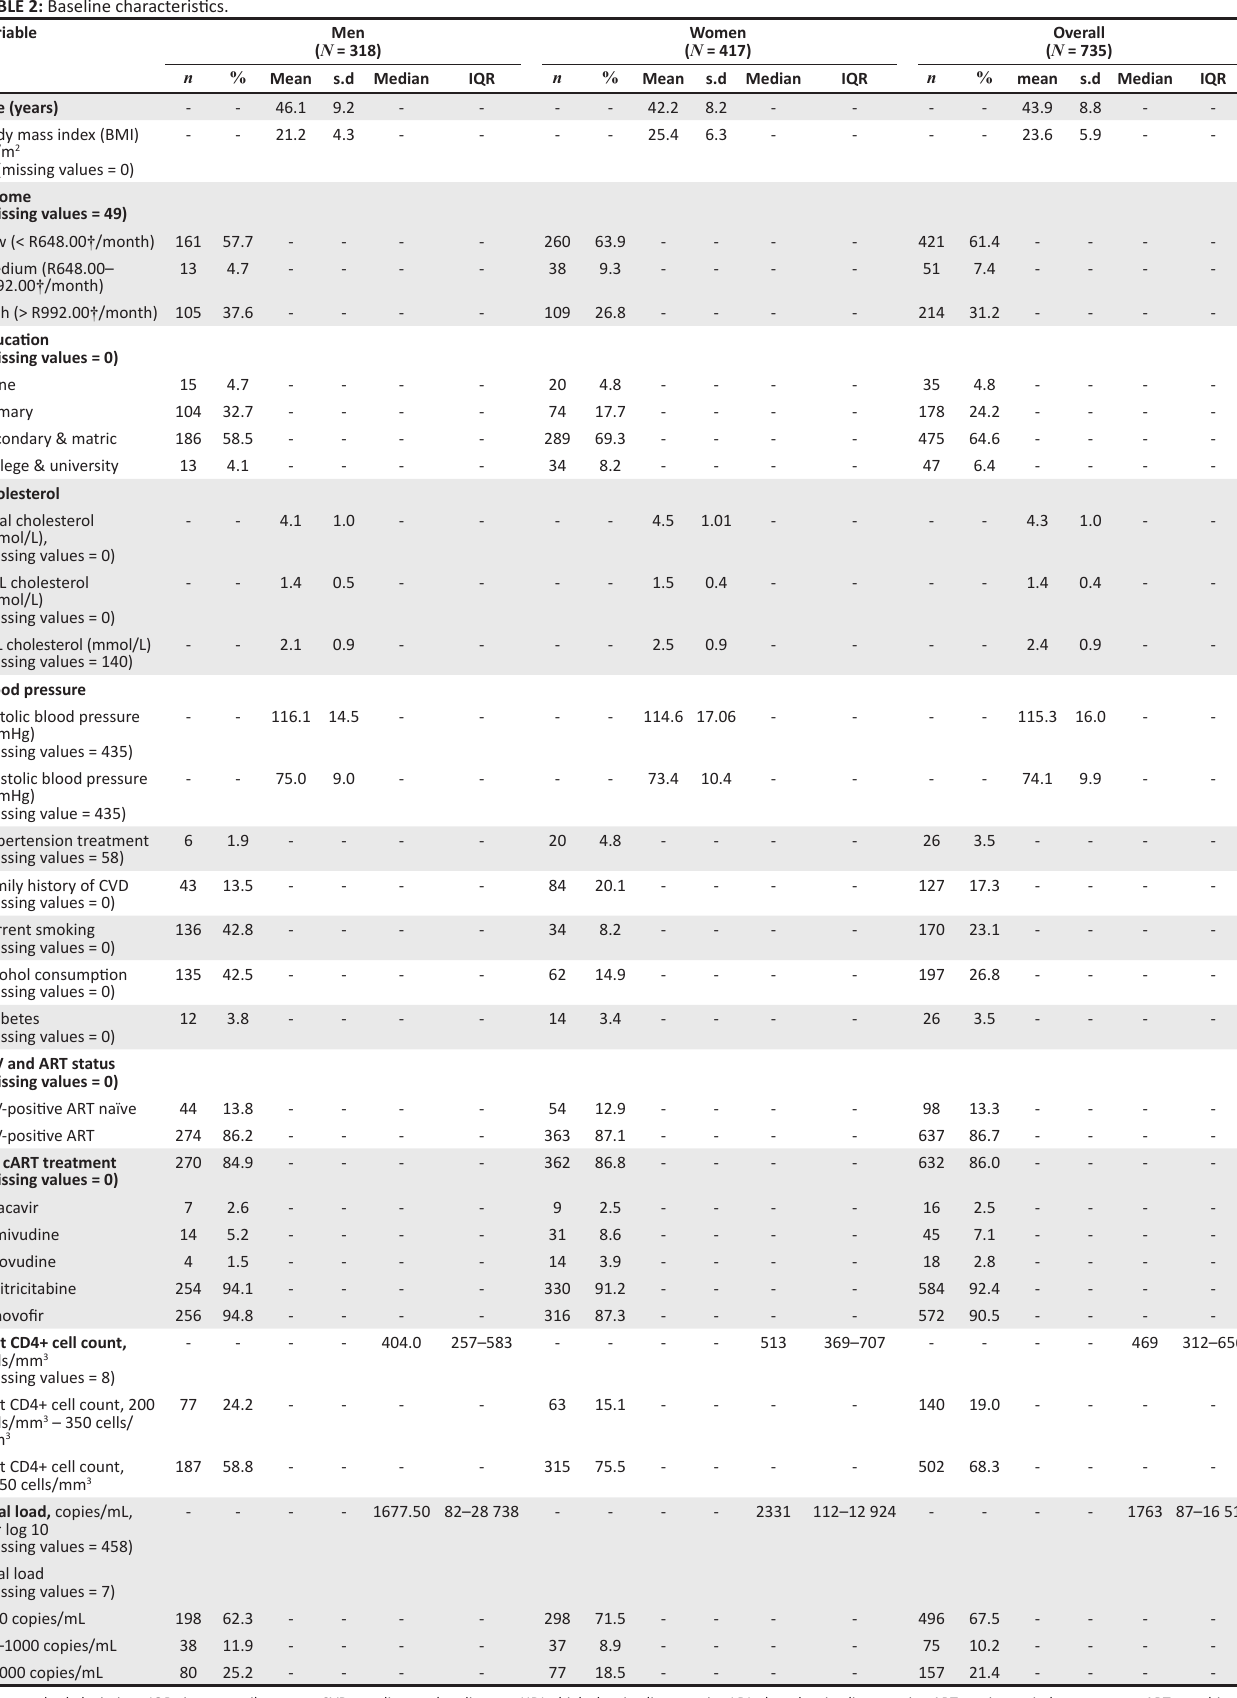
TABLE 2: Baseline